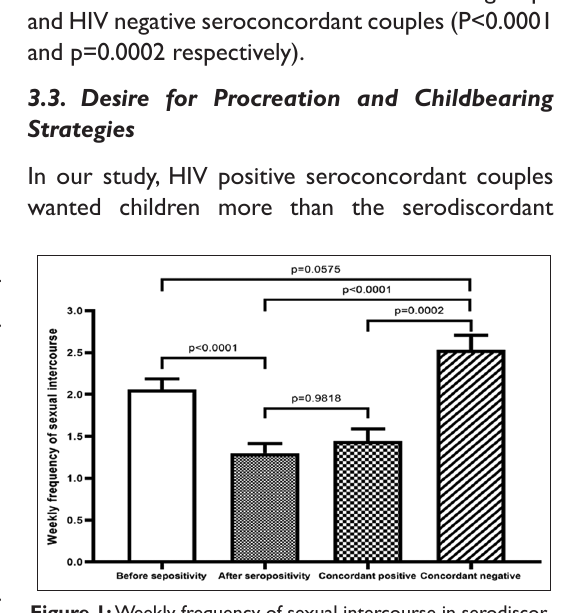
Figure 1: Weekly frequency of sexual intercourse in serodiscor - dant, HIV positive seroconcordant an d HIV negative serocon- cordant couples. Before and after seropositivity refer to sero-discordant couples; concordant positive refers to HIV Positive seroconcor- dant couples and concordant negative refers to HIV negative seroconcordant couples.